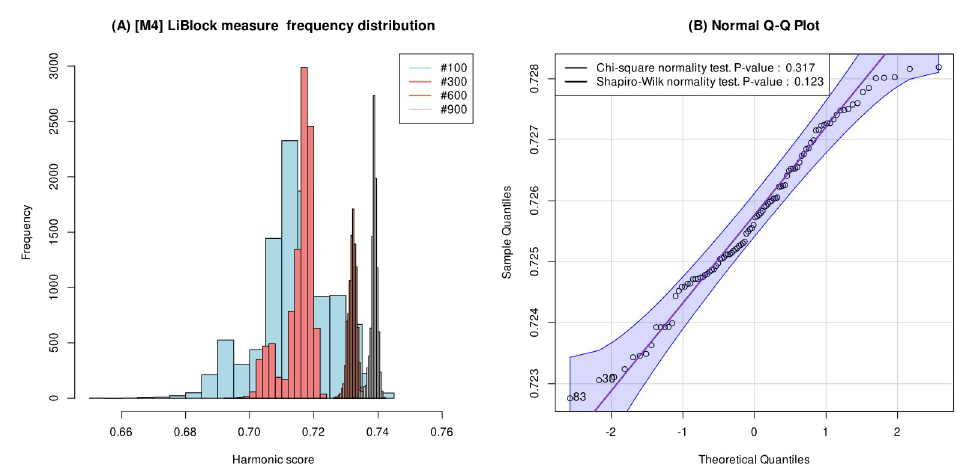
Fig 5. Figure (a) below shows the histogram plots for the harmonic score obtained by the Li-Block measure [M4] in evaluating the sentence similarity of 10,000 different equal-size subsets of sentence pairs extracted from the MedSTS dataset. Each histogram plot represents the frequency distribution of 10,000 samples of the harmonic score with subsets of sentence pairs with sizes: 100, 300, 600, and 900. Figure (b) shows the Q-Q plot normality test for the harmonic score obtained for a random subset with size 100, along with the p-values reported by the Shapiro-Wilk and Chi-square normality tests.